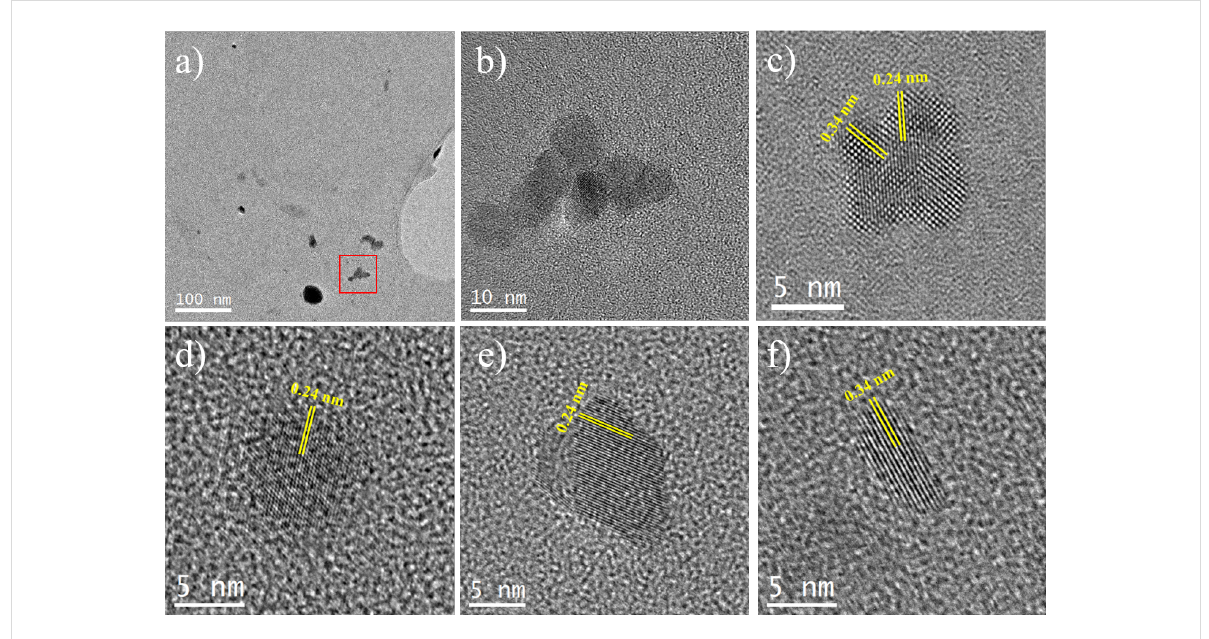
Figure 2: a) and b) General TEM micrographs of the green carbon quantum dot sample, showing the presence of small nanoparticles, and c–f) HRTEM micrographs of several individual nanoparticles identified as carbon quantum dots, where the 0.34 nm lattice spacing value corresponds to the (002) plane, and the 0.24 nm lattice spacing is formed by overlapping two (002)